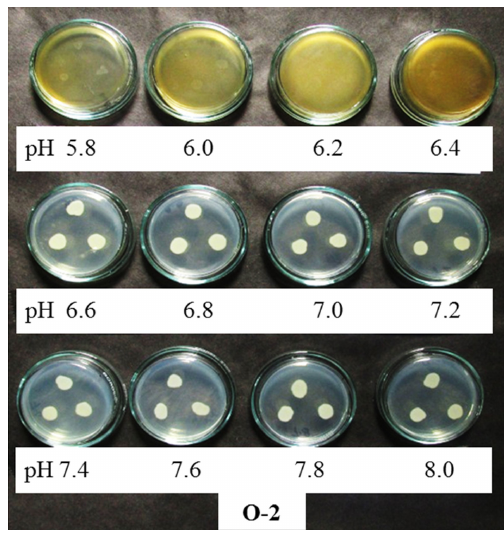
Fig. 3. Growth of O-2 at different pH